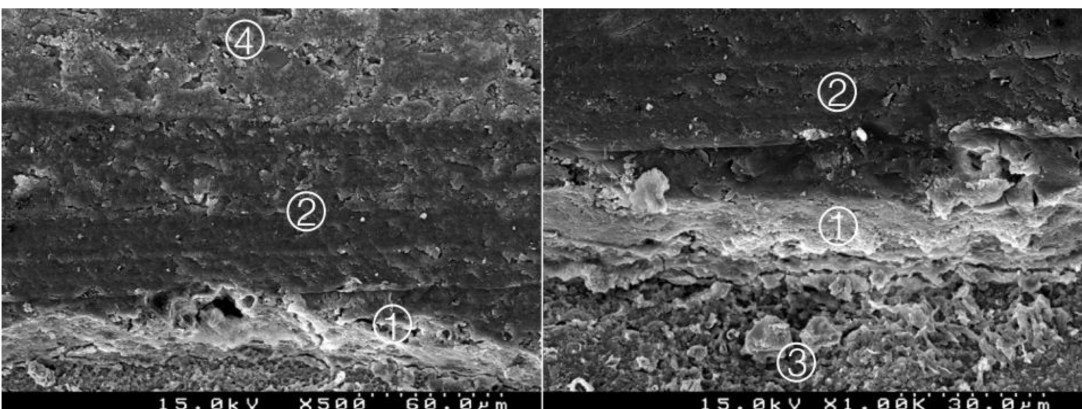
Figure 6. Group 4 (BiodentineSE17): some interpenetration between the adhesive system and CSC. A less deep hybrid layer is observed 1 (cid:13) between the adhesive with a thick layer 2 (cid:13) and the Biodentine TM 3 (cid:13) . Composite resin 4 (cid:13) (original magnification 500 × and 1000 ×